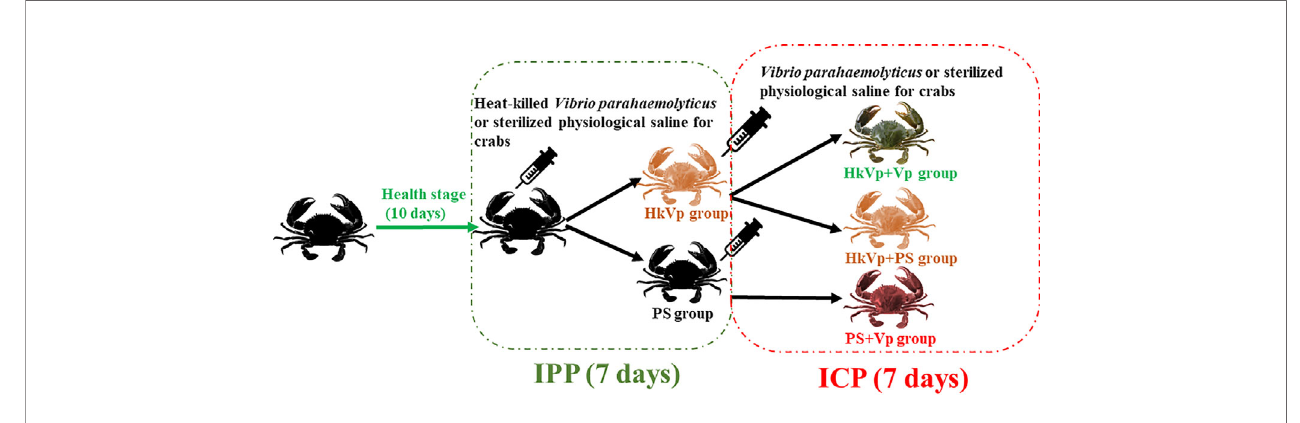
FIGURE 1 | Experimental design of S. paramamosain receiving heat-killed V. parahaemolyticus (IPP) and live V. parahaemolyticus